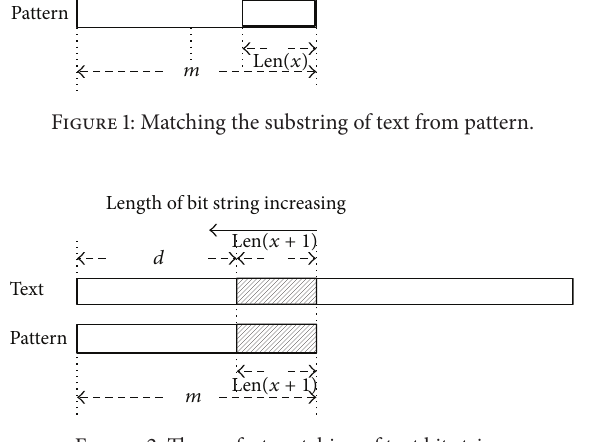
Figure 2: The perfect matching of text bit